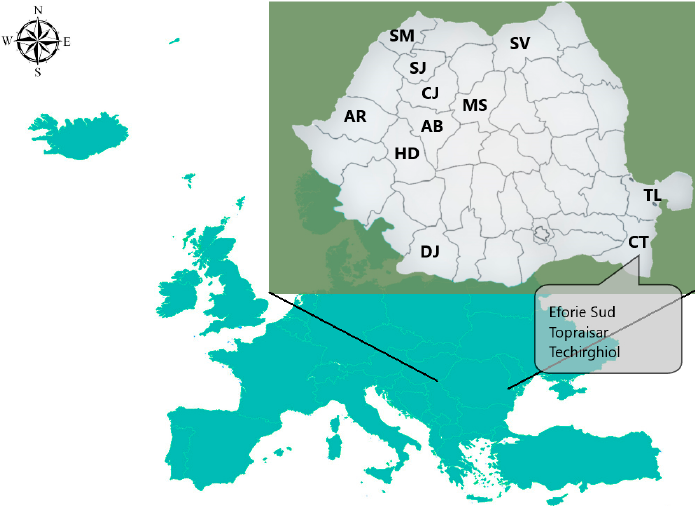
Figure 4. The map of the egg sample’s locations. AB, Alba County; AR, Arad County; CJ, Cluj County; CT, Constanta County; DJ, Dolj County; HD, Hunedoara County; MS, Mures County; SM, Satu Mare County; SJ, Salaj County; SV, Suceava County, TL, Tulcea County.